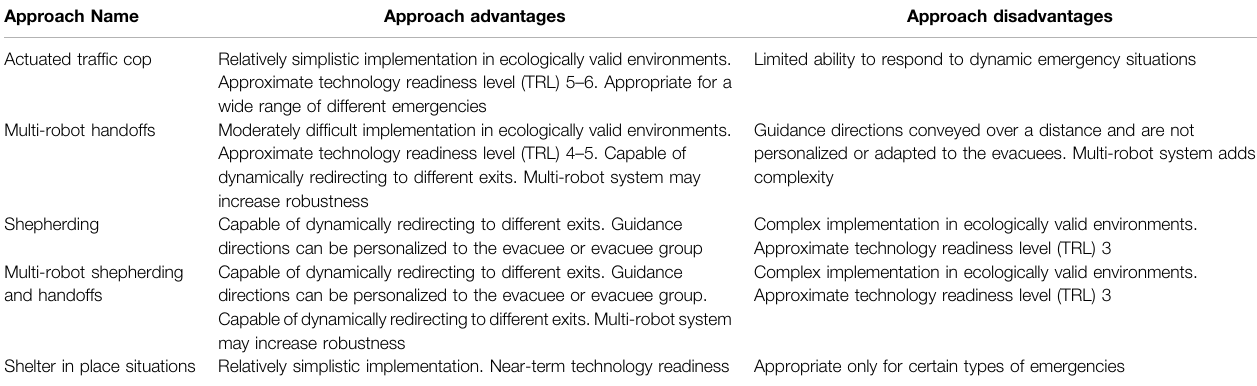
TABLE 1 | Summary of different robot-guided evacuation approach advantages and